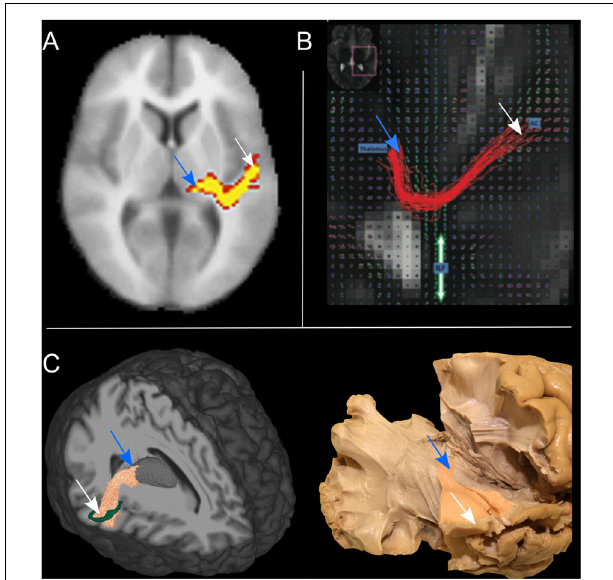
FIGURE 4 | The tractography reconstruction of the acoustic radiation (AR) in three different studies. (A) 3D volumetric reconstruction of the right AR in one subject using a multi-tensor model and probabilistic tractography. Voxels are color-coded from 10 (red) to 50 (yellow) samples passing through the voxel (adapted with permission from Behrens et al., 2007). (B) The panel shows the streamlines of the right AR in axial view, as reconstructed in one subject using q-ball imaging and probabilistic tractography. The location of the thalamus and auditory cortex (AC) are specified by the blue boxes. The figure also shows the orientation distribution functions (ODF) corresponding to the inferior longitudinal fasciculus (ILF), highlighted by the green arrow (adapted with permissions from Berman et al., 2013). (C) Left: 3D tractography reconstruction of the right AR in one subject using constrained spherical deconvolution models and probabilistic tractography. A 3D rendering of the thalamus is also shown in gray and the borders of HG in green. Right: Klinger’s post-mortem blunt dissection of the right AR (modified from Maffei et al., 2018). In all three panels the location of thalamus (blue arrow) and auditory cortex (white arrow) are